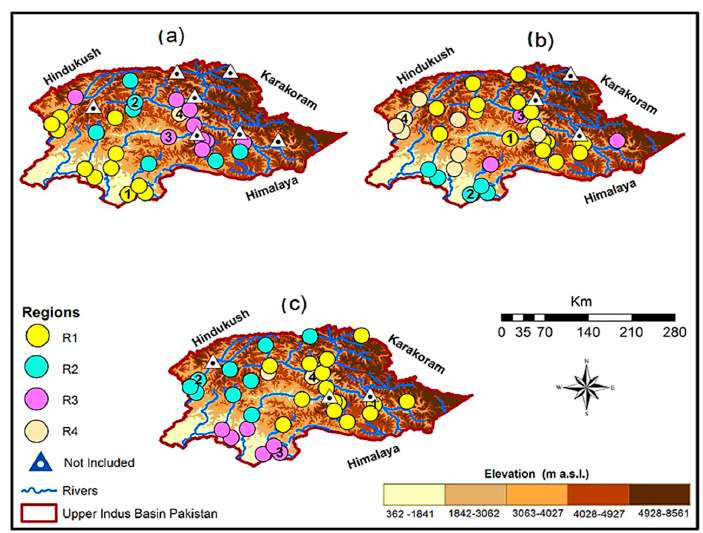
Figure 3. It is the same as Figure 2 but showing regions under the high ‐ altitude Upper Indus Basin (UIB) regionalization experiment. Adapted with permission from ref. [43].